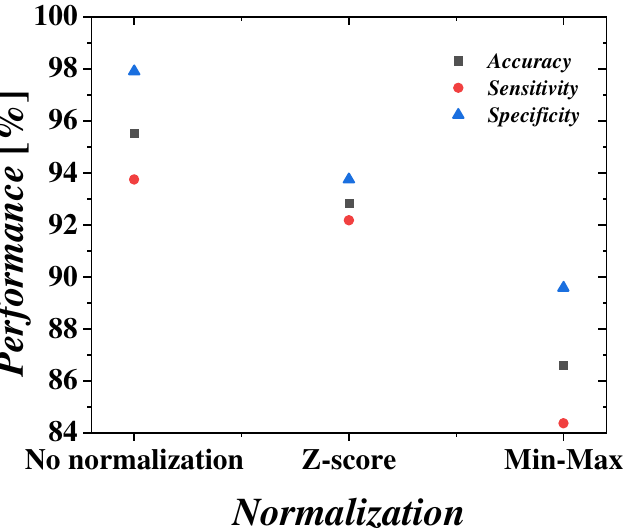
Figure 9. Validation data performances of the proposed STM-LSTM-based fall detection system, applying normalization methods.